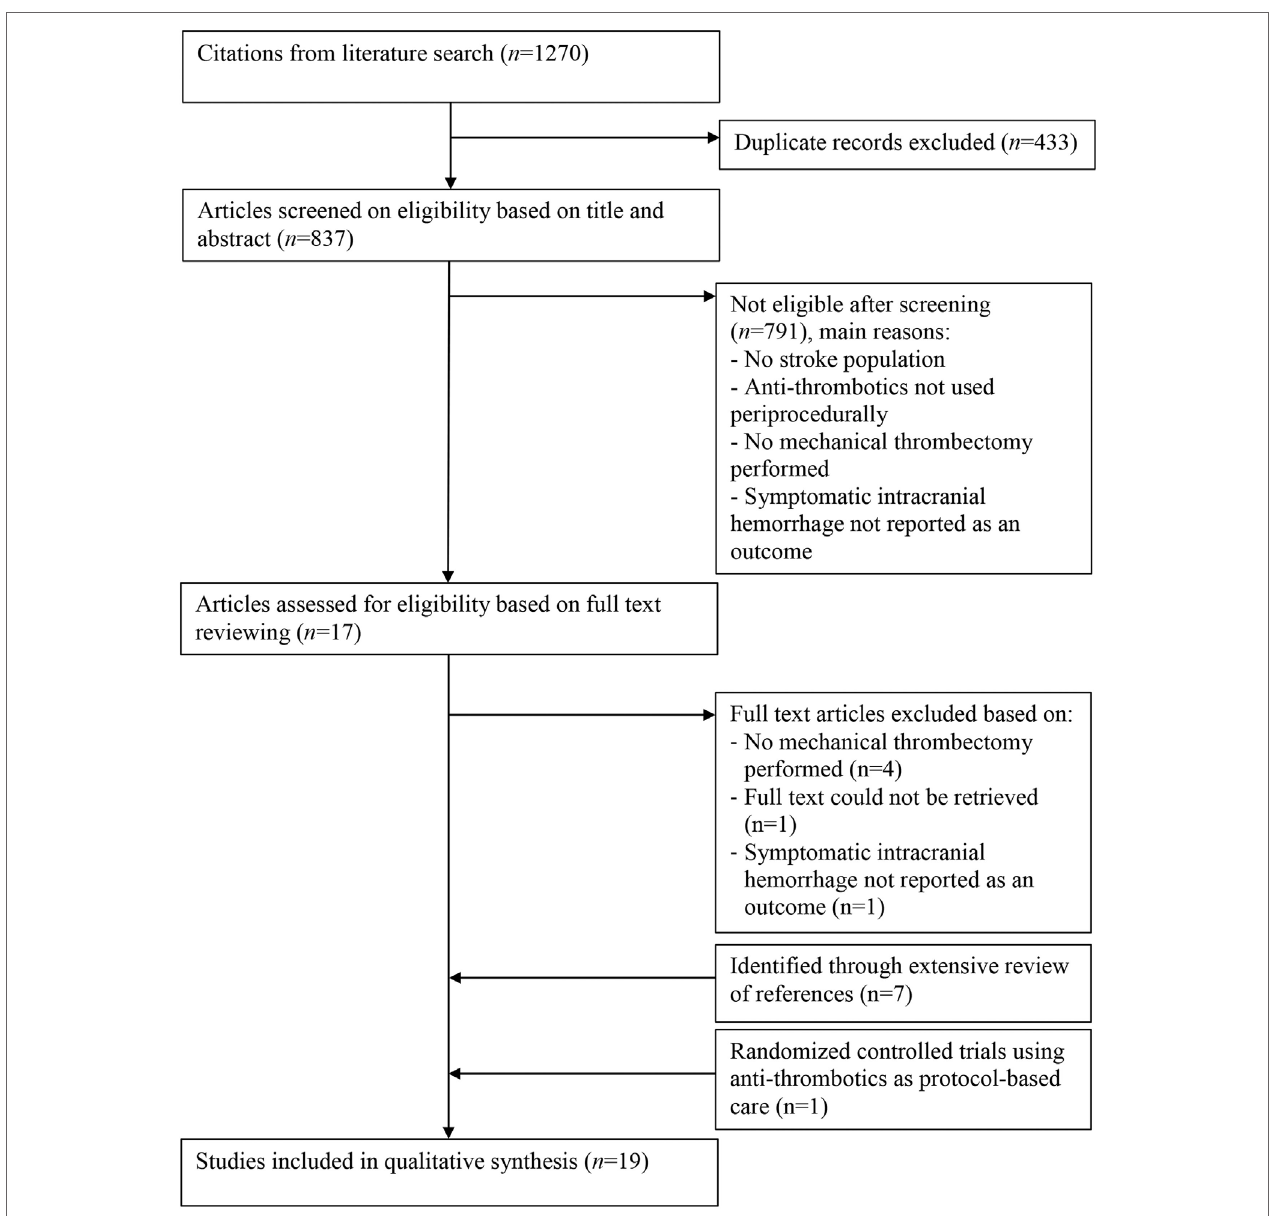
FiGURe 1 | Flowchart of the systematic literature